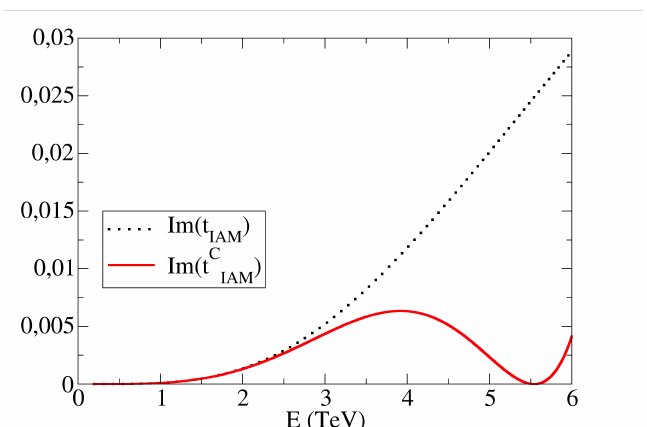
Figure 10: The conventional IAM (dotted) applied to the amplitude t fails to re- produce the zero associated to a CDD pole. However, applying the method to the ) , leading to the small modification of Eq. (29), correctly repro- amplitude t / ( s − s C duces the CDD zero in the amplitude (solid line).